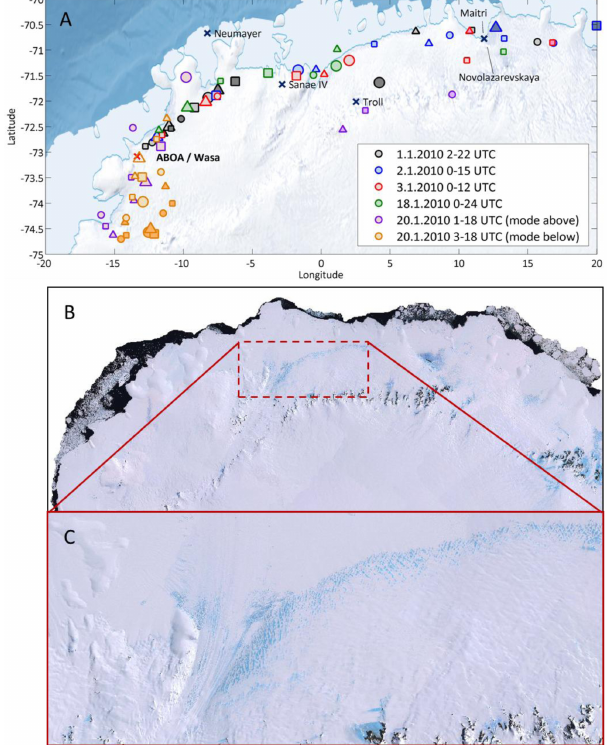
Fig. 8. Origin of Aitken mode particles associated with the observed regional nucleation events. Panel (A) shows the estimated source ar- eas of Aitken mode particles calculated along back trajectories by assuming that the particles grew in size during their atmospheric transportation at the same rate as observed in our measurement site. The “initial diameter” of these particles was assumed to be 5nm (circle), 10nm (square) or 15nm (triangle), which represents the uncertainties in the very fast growth of nucleated particles in the immediate vicinity of their emission source as seen during the local events in Figs. 3 and 4. The different colours of the markers (see the legend) refer to different nucleation events or, in case of 20 January, to two separate Aitken modes observed during the same event. For each event, we visually selected 6 spots in the particle size vs. time space that we followed using trajectories: the lower (light-coloured marker) and upper (dark-coloured marker) end of the Aitken mode in the middle (large marker) of the event or at the beginning or end (small marker) of the event. Panels (B) and (C) show LANDSAT- satellite images over the same area showing larger areas of meltwa- ter in the border between the shelf ice and ice sheet. Satellite images are downloaded from the LIMA web page,